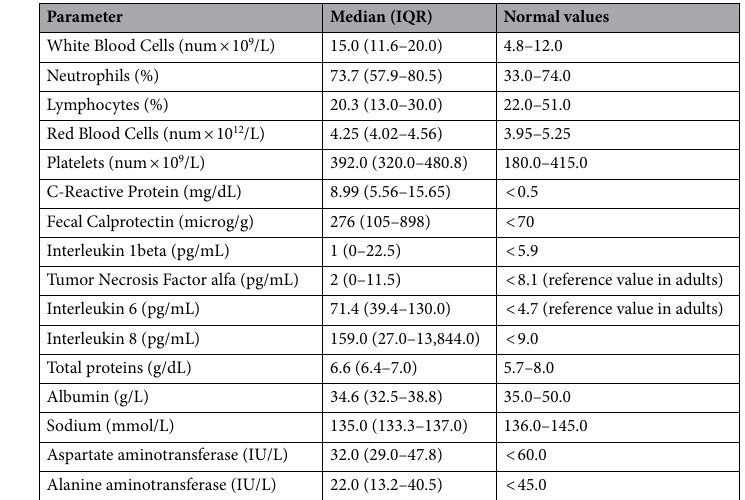
Table 1. Laboratory values of patients diagnosed with KD enrolled in the